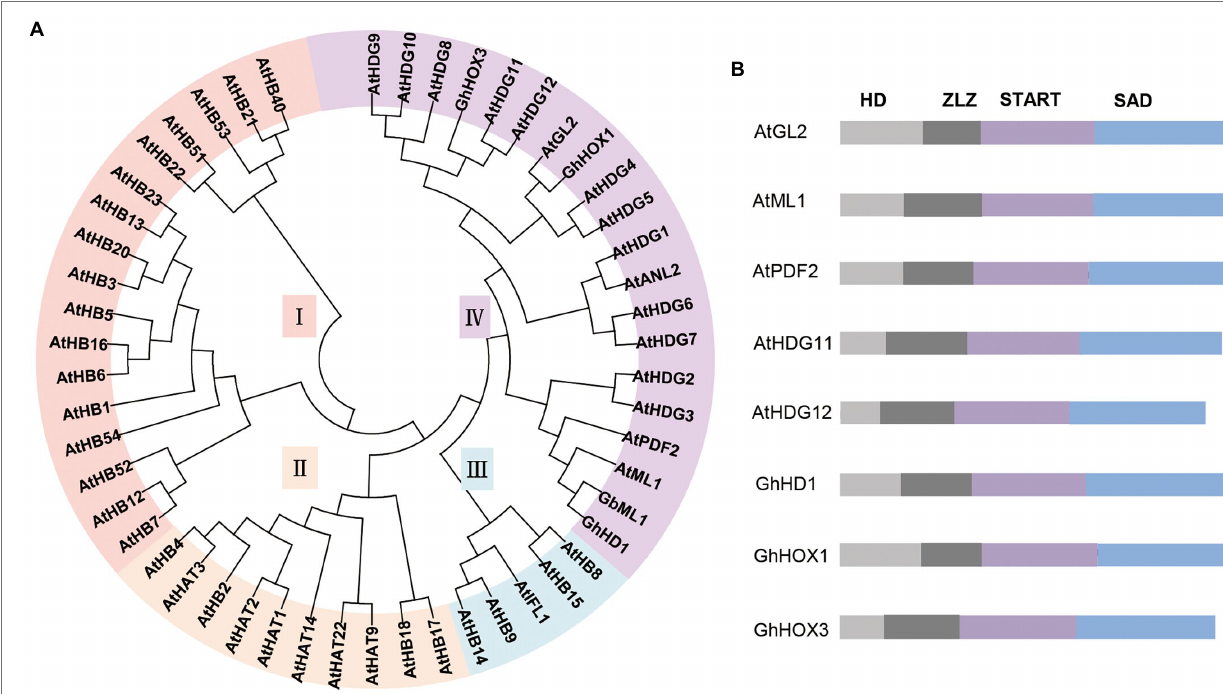
FIGURE 3 | Relationships of HD-ZIP TF members in Arabidopsis and cotton. (A) Phylogenetic tree of HD-ZIP TFs in Arabidopsis and cotton by the neighbor-end joining method using MEGA 10.0. (B) Gene structure of the HD-ZIP IV TFs in Arabidopsis and cotton. ATHB1/HAT5 (At3g01470), ATHB3/HAT7 (At5g15150), ATHB5 (At5g65310), ATHB6 (At2g22430), ATHB7 (At2g46680), ATHB12 (At3g61890), ATHB13 (At1g69780), ATHB16 (At4g40060), ATHB20 (At3g01220), ATHB21 (At2g18550), ATHB22 (At2g36610), ATHB23 (At1g26960), ATHB40 (At4g36740), ATHB51 (At5g03790), ATHB52 (At5g53980), ATHB53 (At5g66700), ATHB54 (At1g27050), ATHB2/HAT4 (At4g16780), ATHB4 (At2g44910), ATHB17 (At2g01430), ATHB18 (At1g70920), HAT1 (At4g17460), HAT2 (At5g47370), HAT3 (At3g60390), HAT9 (At2g22800), HAT14 (At5g06710), HAT22 (At4g37790), ATHB8 (At4g32880), PHAVOLUTA/ATHB9 (At1g30490), PHABULOSA/ATHB14 (At2g34710), CORONA/ATHB15 (At1g52150), REVOLUTA/IFL1 (At5g60690), AtGL2 (At1g79840), AtML1 (At4g21750), AtPDF2 (At4g04890), AtANL2 (At4g00730), AtHDG1 (At3g61150), AtHDG2 (At1g05230), AtHDG3 (At2g32370), AtHDG4 (At4g17710), AtHDG5 (At5g46880), AtHDG6 (At4g25530), AtHDG7 (At5g52170), AtHDG8 (At3g03260), AtHDG9 (At5g17320), AtHDG10 (At1g34650), AtHDG11 (At1g73360), AtHDG12 (At1g17920), GhHD1 (Gh_A06G1283), GhHOX1 (AF530913), GhHOX3